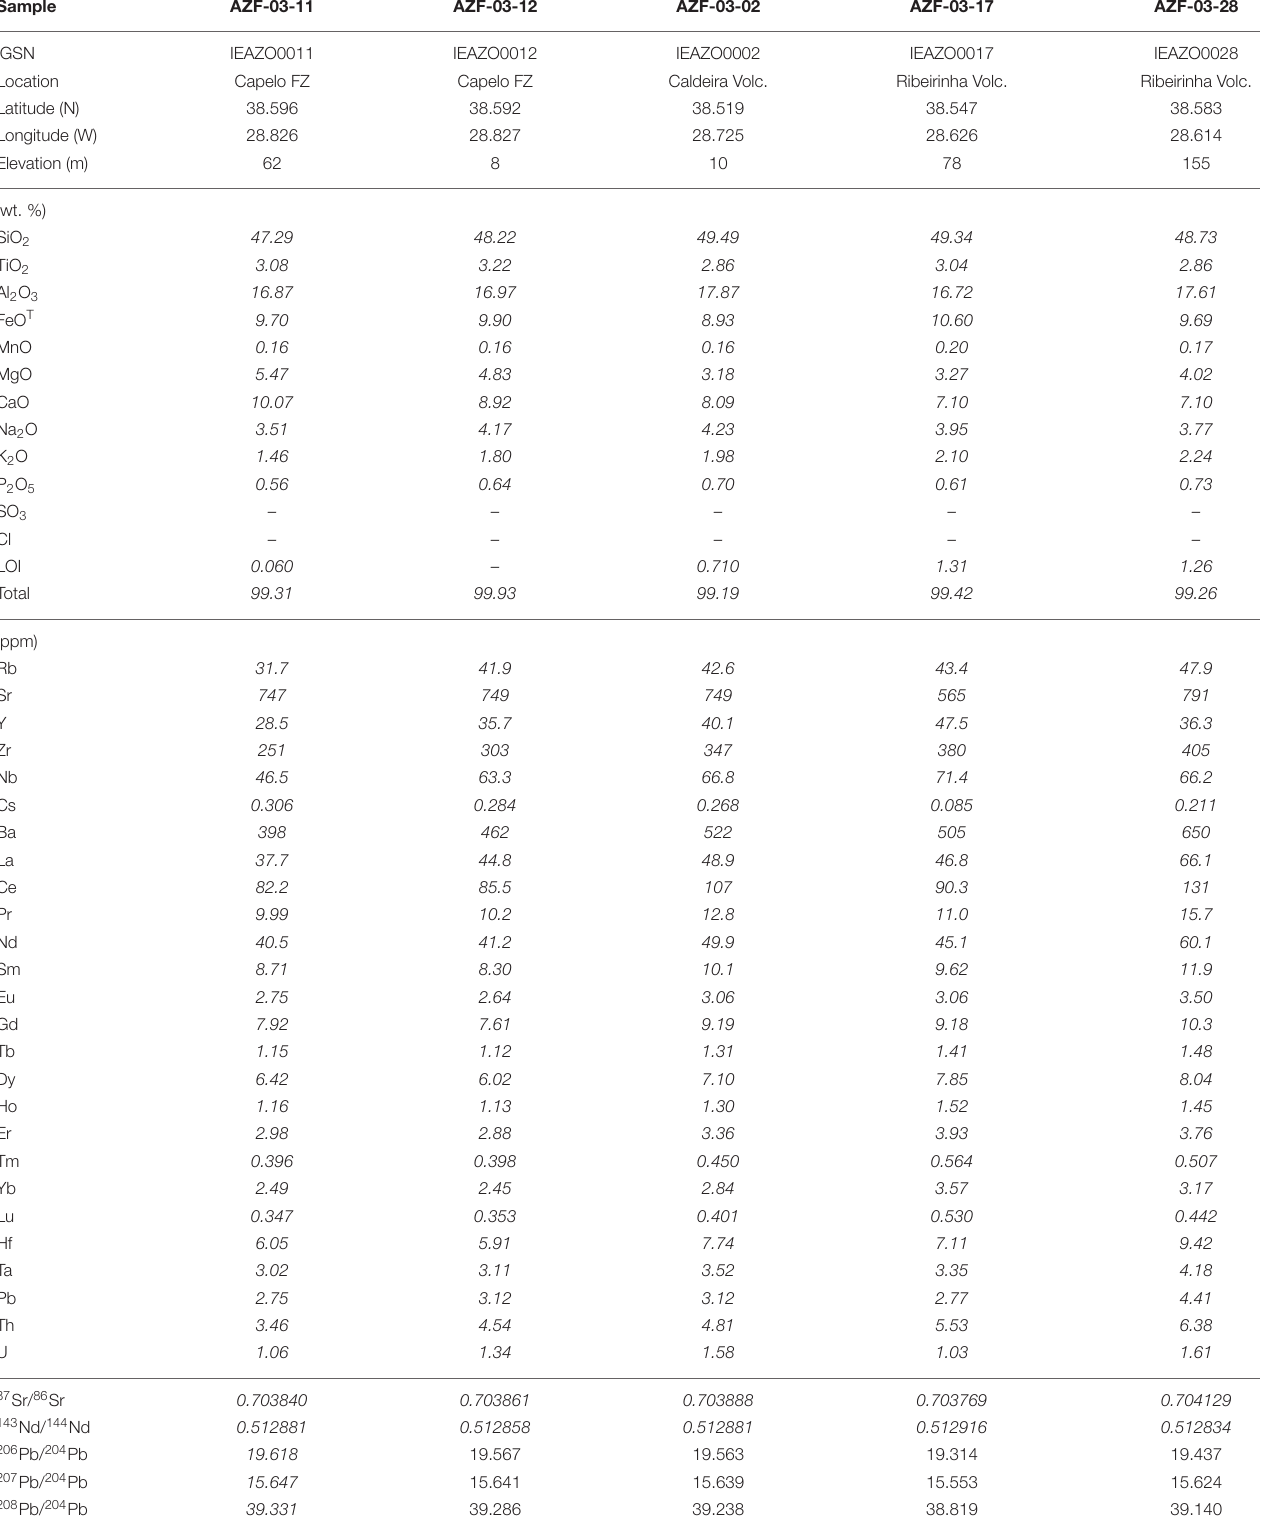
TABLE 1 | Comprehensive selected major and trace elements, and Sr-Nd-Pb isotopes from Faial Island and submarine volcanic rift zones.